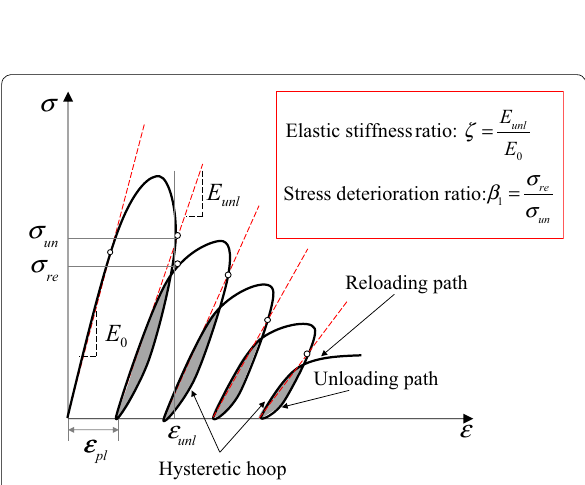
Fig. 7 Ideal schematic of cyclc compressive process of concrete